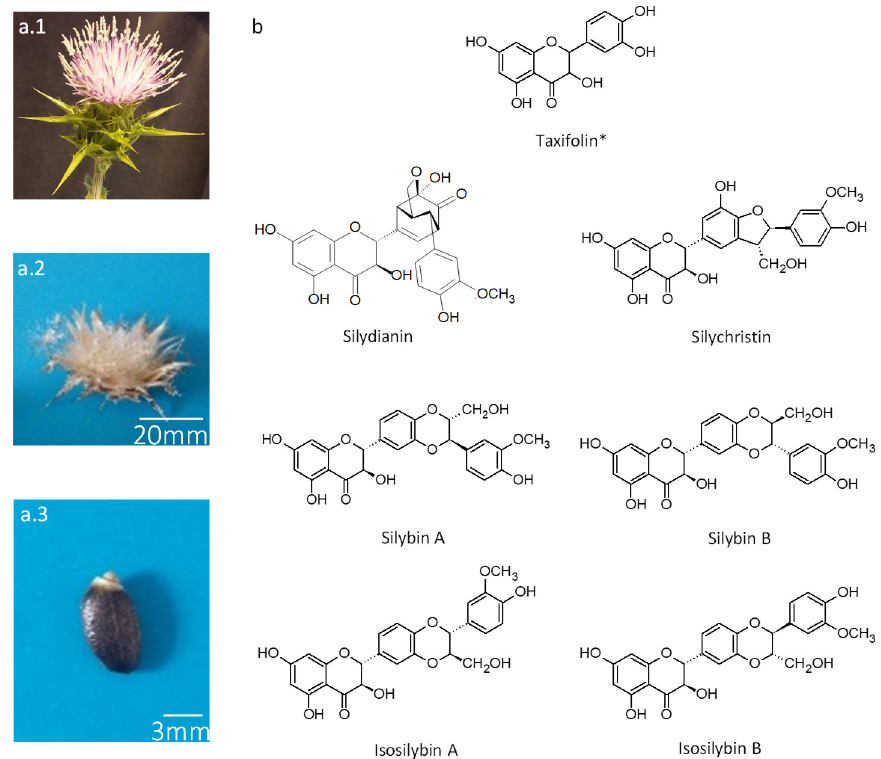
Figure 1. ( a ) Representative pictures of a flowering capitulum ( a.1 ), of an open mature capitulum bearing mature fruit (achenes) ( a.2 ); and of a mature fruit (achene) ( a.3 ) of milk thistle ( S. marianum ) ( b ) Structures of the six flavonolignans (silychristin (SILC), silydianin (SILD), silybin A (SILA), silybin B (SILB), isosilybin A (ISILA) and isosilybin B (ISILB)) and one flavonoid (*, taxifolin, TAX)) from